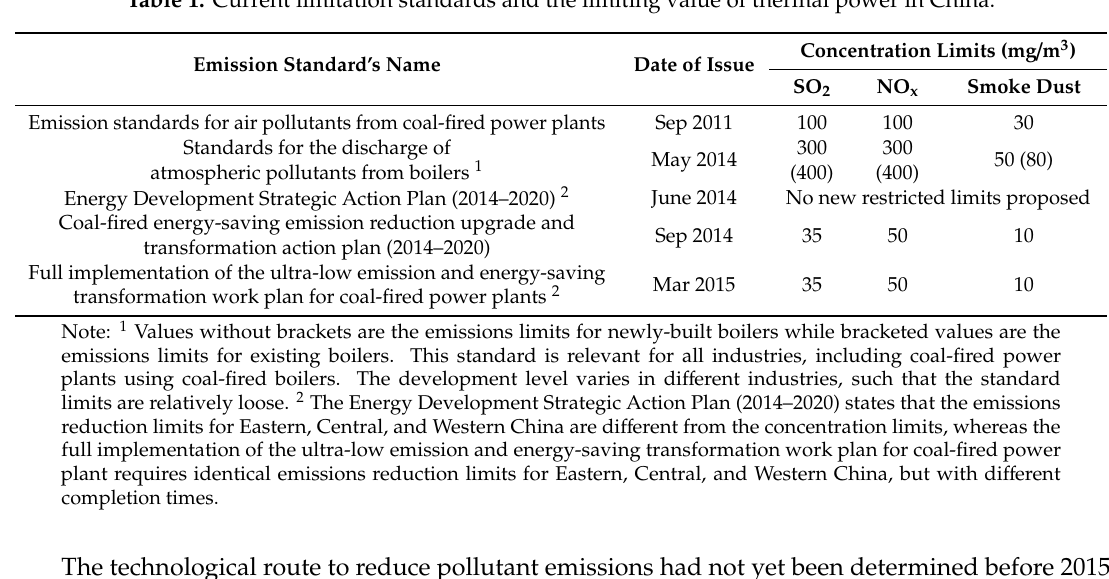
Table 1. Current limitation standards and the limiting value of thermal power in